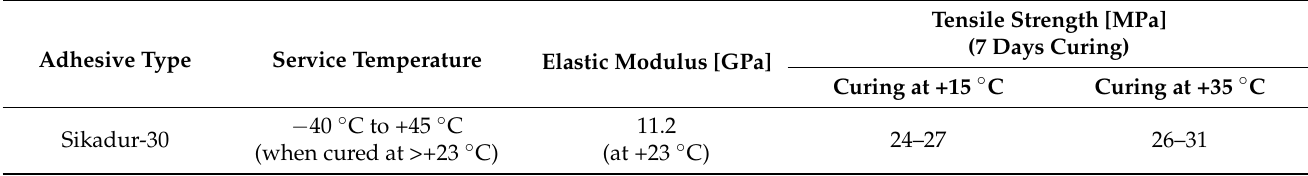
Table 4. Adhesive mechanical characteristics.